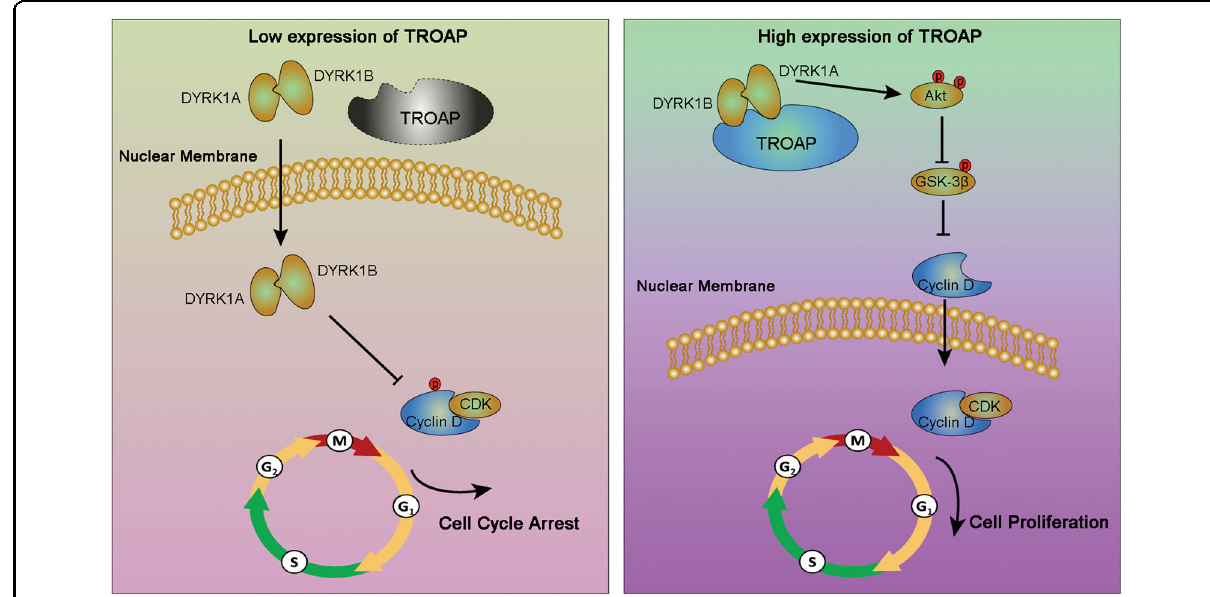
Fig. 8 High expression of TROAP enhances HCC cell proliferation via DYRK1/Akt/GSK-3 β signaling. In normal liver tissues, the expression of TROAP is downregulated by miR-142-5p. Intranuclear DYRK1A and DYRK1B induce Cyclin D1 proteolysis and cell cycle arrest. Inversely, TROAP highly expresses in HCC tissues and directly binds DYRK1A and DYRK1B, which forms a protein complex resulting in the cytoplasmic retention of DYRK1A and DYRK1B. Cytoplasmic DYRK1 activates Akt/GSK-3 β signaling and enhances the stability and nuclear localization of Cyclin D1, which accelerates cell cycle process and promotes the malignant proliferation of HCC